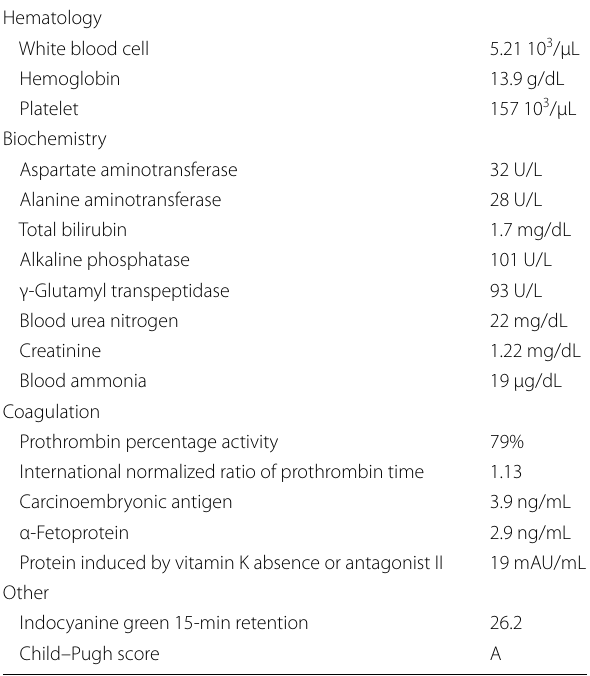
Table 1 Laboratory findings before